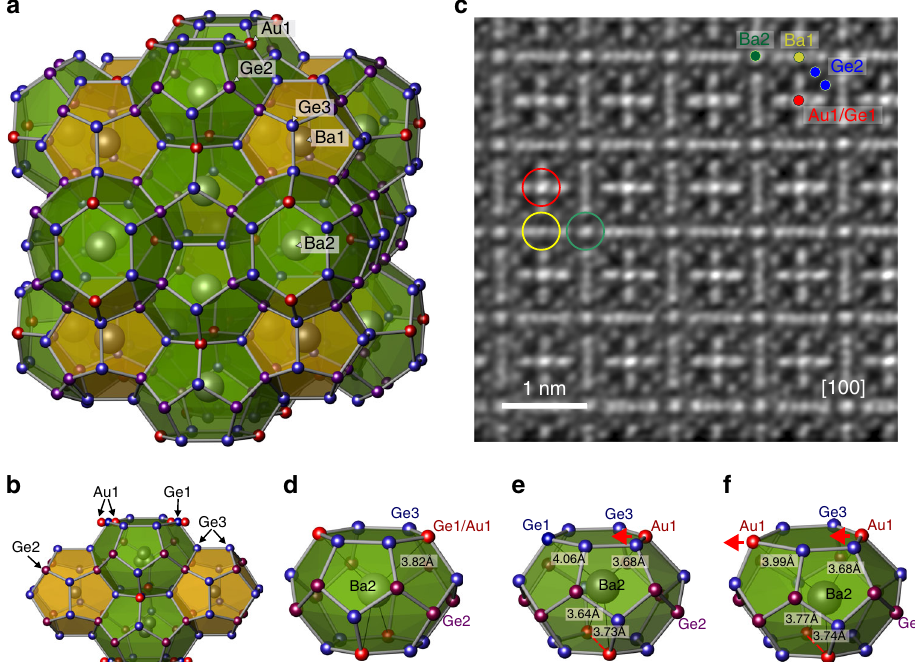
Fig. 1 Crystal structure and local atomic arrangements of Ba 7.81 Ge 40.67 Au 5.33 . a Ordered clathrate-I model with the composition Ba 8 Ge 40 Au 6 showing the three-dimensional Ge/Au framework with 20-vertices polyhedra ( orange ) and 24-vertices polyhedra ( green ), occupied by Ba1 (Wyckoff site 2a ) and Ba2 ( 6d ) atoms, respectively. Au atoms on the 6c site are shown in red . b Atomic arrangements around Ba2 and Ge1/Au1 positions; red arrows mark the shift of the Au1 atoms with respect to the 6c site. c Atomic-resolution Scanning Transmission Electron Spectroscopy (STEM) image along the [100] direction reveals strong displacement of atoms from the ideal positions in the regions of Ba2 ( green ) and Au1/Ge1 ( red ) positions in comparison with the Ba1 ones ( yellow ). Additional deviations from the translational symmetry can be recognized in several regions of the image. d Ideal ordered arrangement in the Ba2 polyhedron with Ba2 in 6d site and equivalent Ba2-Ge1-Au1 distances for a hypothetical undistorted model. e A possible atomic arrangement in the Ba2 polyhedron with three Au atoms at Au1 site, Ba2 displaced from the 6d site and smaller Ba2-Au1 distances due to the Ba-Au interactions; f Atomic arrangement with 3 Au atoms as obtained by using positions from ab initio calculation on a 2×2×2 supercell and the experimental lattice parameter. The distances compare well with experimental data in